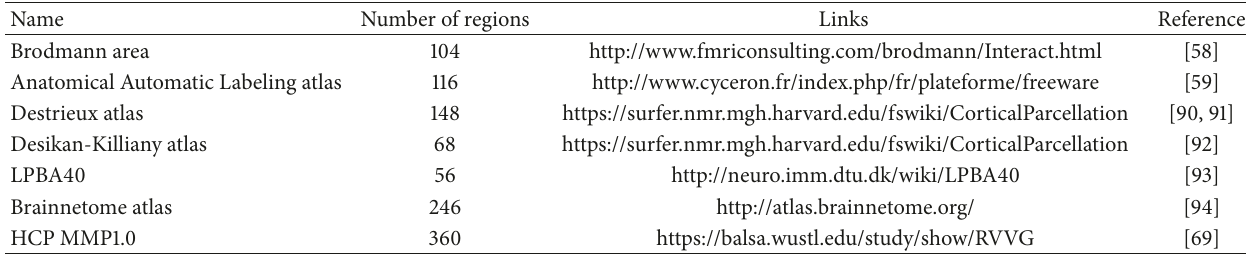
Table 1: Some common atlas in brain network